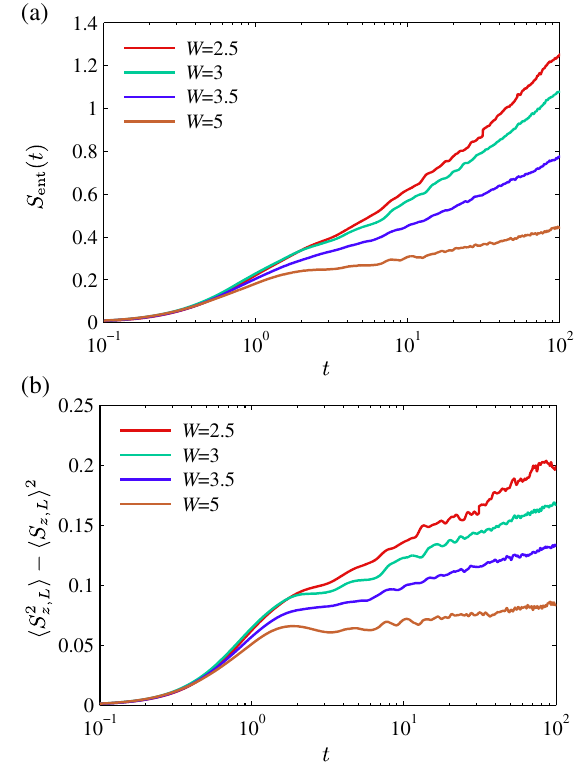
FIG. 5. Dynamics of entanglement entropy (a) and particle number fluctuations (b) across the MBL transition. The system was initialized in a product state where each spin is up or down. The entanglement entropy has faster than-logarithmic growth in the delocalized phase. The particle number fluctuations grow logarithmically in the vicinity of the